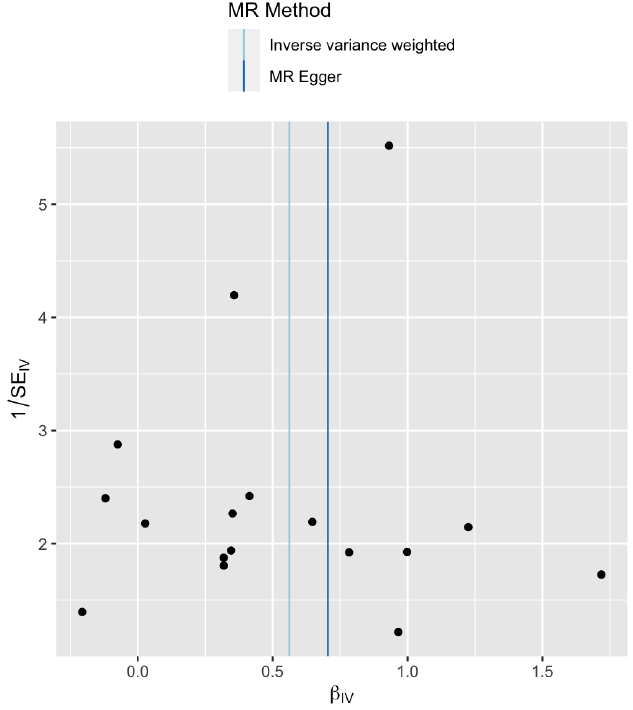
Figure 3. Funnel plot of precision (1/ SE ) versus causal estimate ˆ β for late pubertal